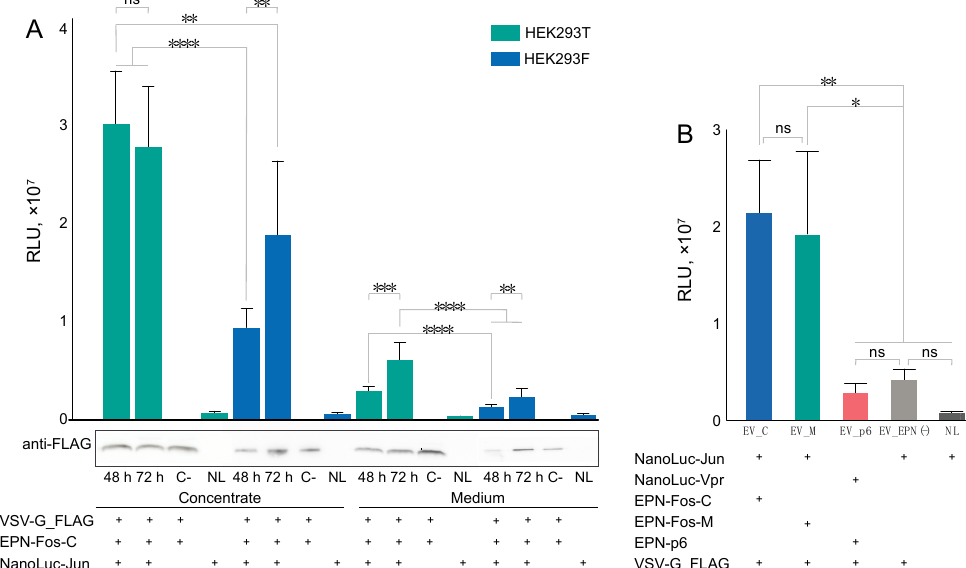
Figure 3. Expression level of EVs loaded with NanoLuc-Jun. ( A ) Optimization of EV production in eukaryotic cells. Data are shown for cells’ supernatant (Medium) before concentration steps and EVs concentrated with 100 kDa membrane (Concentrate). “48 h”, “72 h”—samples containing EVs with EPN nanocages loaded with NanoLuc-Jun collected after 48 h and 72 h of expression, respectively. “C-”—samples containing EVs with empty EPN nanocages (without NanoLuc-Jun), collected after 72 h of expression (negative control). ( B ) EV_C and EV_M samples produce the same level of EVs loaded with NanoLuc. Relative Light Units (RLU) were measured. EVs from cells-producer line were collected after 48 h or 72 h, concentrated and washed three times with PBS as described in Materials and Methods. “NL”—samples containing NanoLuc-Jun expressed without VSV-G and EPN for 72 h (control). Each experiment was performed in triplicate. Mean ± SD is shown. * p < 0.05, ** p < 0.01, *** p < 0.001, **** p < 0.0001, ns—not significant, two-tailed Student’s t -test. Utilization of each of the genetic constructs (pCMV-VSVG, pCMV-EPN-Fos-C, pCMV-EPN-Fos-M, pCMV-EPN-p6, pCMV-NanoLuc-Jun, pCMV-NanoLuc-Vpr) for the production of EVs is indicated as “+”.